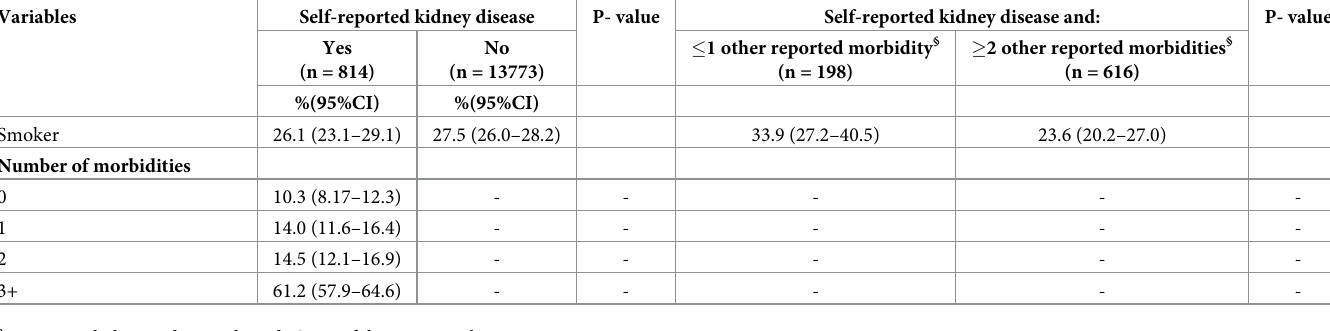
quintile. No differences in the type of settlement and according to the region and smoking sta- tus were found between subjects with and without SRKD. Two-thirds of respondents who reported presence of KD (75.7%), also reported presence of two or more other chronic dis- eases. Respondents who reported 2 or more morbidities besides KD, compared to respondents who reported KD only and those who reported 1 other morbidity besides KD, were signifi- cantly older, more frequently women, lived without partner, had middle/low formal education and had BMI above normal range. Borderline statistical difference for wealth index (p = 0.05) was found between SRKD respondents having with (cid:20) 1 and (cid:21) 2 morbidities (Table 1). Prevalence of all analyzed chronic diseases and functional limitations was significantly higher in respondents who reported presence of KD than those who did not report KD (Table 2). The most prevalent chronic diseases in respondents who reported KD were cardio- vascular diseases (76.8%), degenerative disorders of bone and joint system (66.1%) and hyper- lipidemia (35.8%). One-fifth of respondents who reported KD (20.9% and 20.1%, respectively) also reported presence of DM and respiratory disease. We found that respiratory disease was 3.7 times, malignancy was 3.6, DM was 3.0 times and urinary incontinence was 9 times more frequently present in SRKD then non-SRKD respondents. Visual impairment (86.9%), mobil- ity difficulty (47.0%) and hearing impairment (30.7%) were the most prevalent functional limi- tations in SRKD respondents. Prevalence rates of all analyzed chronic diseases were the highest among persons who reported (cid:21) 3 morbidities. This was particularly pronounced for HTN, degenerative disorders of bone and joint system and hyperlipidemia (Table 2). Factor analysis performed for respondents who reported KD revealed presence of four fac- tors. The first factor was determined by the association between cirrhosis, malignancy, stroke, urinary incontinence and depression. The second factor included deformity or other chronic problems with the neck spine, deformity or other chronic problem with the lower spine, arthrosis-degenerative joint disease and depression. The third included asthma, COPD and allergy and the fourth clustered HTN, coronary heart disease, hyperlipidemia and DM (Table 3). When obesity was included in the model, factor analysis revealed five factors: factor 1, fac- tor 2 and factor 3 were consisted of the same chronic diseases/conditions; factor 4 combined heart attack, hypertension and coronary heart disease, whereas factor 5 clustered HTN, hyper- lipidemia, DM and obesity (Table 3). Table 4. shows odds ratios (ORs) for associations between chronic diseases, conditions and functional limitations in respondents who reported KD, when controlling for gender,